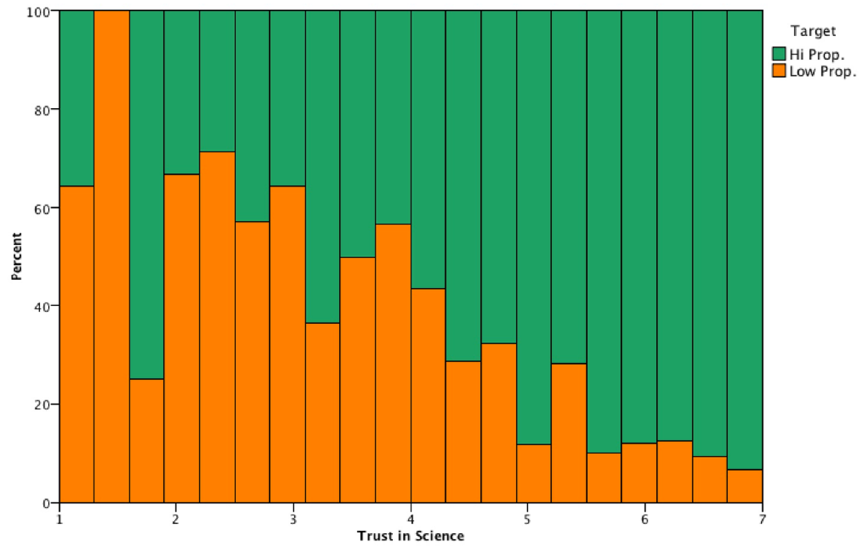
Figure 2. Incidence of high propensity vs. low propensity to vaccination individuals, with respect to trust in science levels.